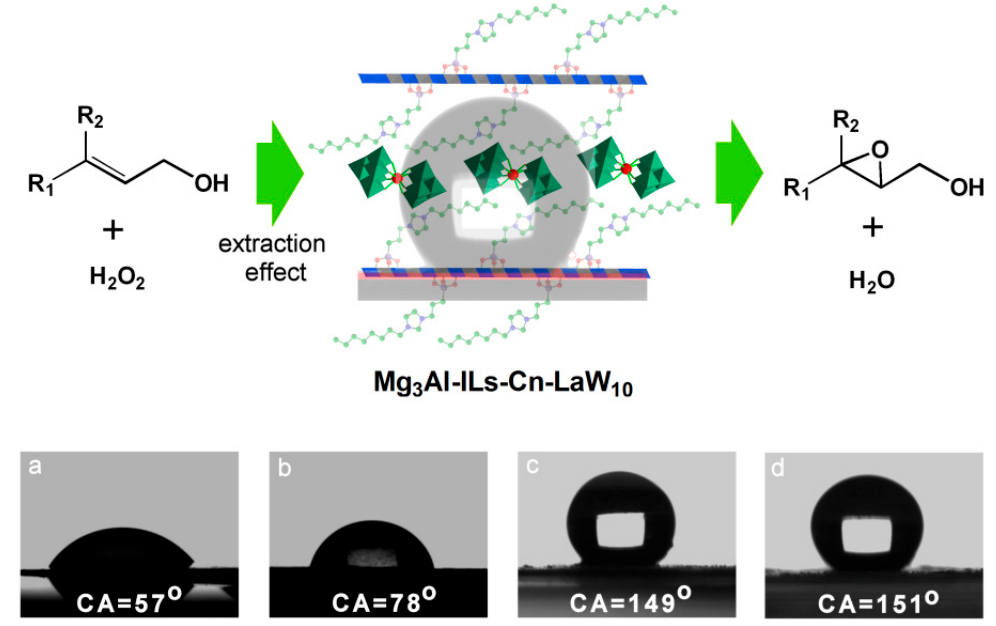
Figure 11. Top : schematic diagram of the catalytic process; Bottom : the water contact angle measurements of: ( a ) Mg 3 Al ‐ LaW 10 ; ( b ) Mg 3 Al ‐ ILs ‐ C 4 ‐ LaW 10 ; ( c ) Mg 3 Al ‐ ILs ‐ C 8 ‐ LaW 10 ; and ( d ) Mg 3 Al ‐ ILs ‐ C 12 ‐ LaW 10 Reproduced from Ref. [66], Copyright 2017, WILEY ‐ VCH.